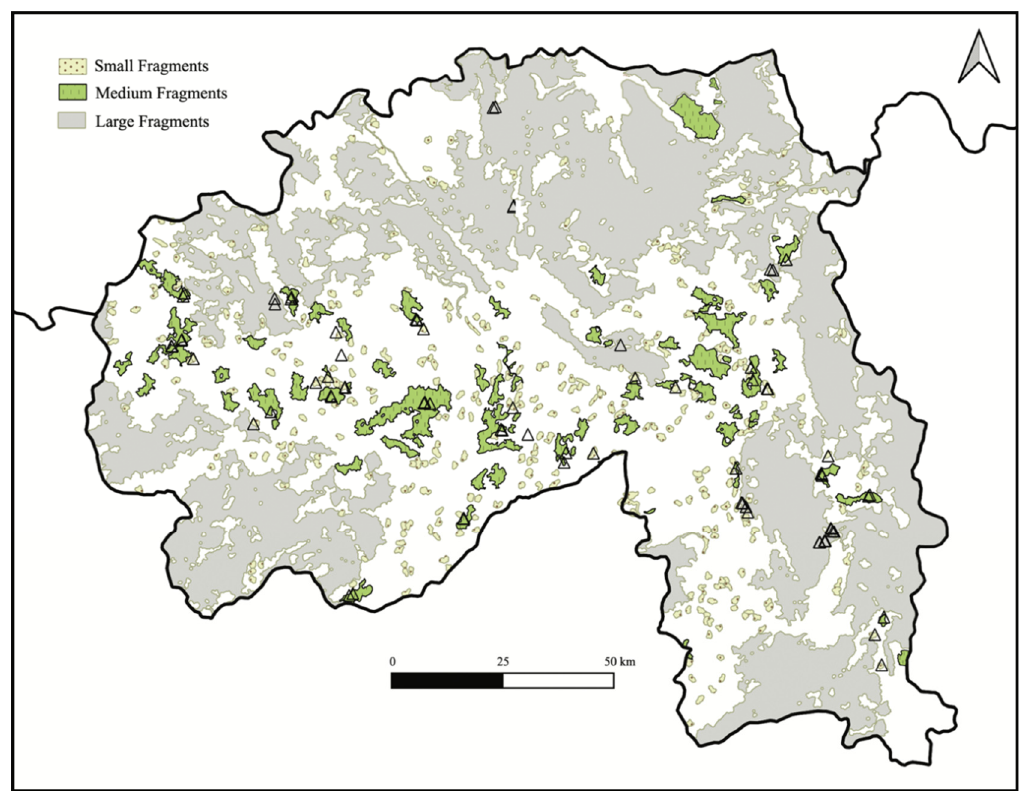
Figure 1. Map showing the tropical fragmented forest landscape in the Xishuangbanna prefecture. Fragments were identified using the QGIS software and the Landsat-5 Thematic Mapper. Yellow colour indicates small forest fragments (0.4–1 km 2 ), green colour indicates medium forest fragments (1–10 km 2 ), and grey colour indicates large forest fragments (>10 km 2 ). The triangles represent the study